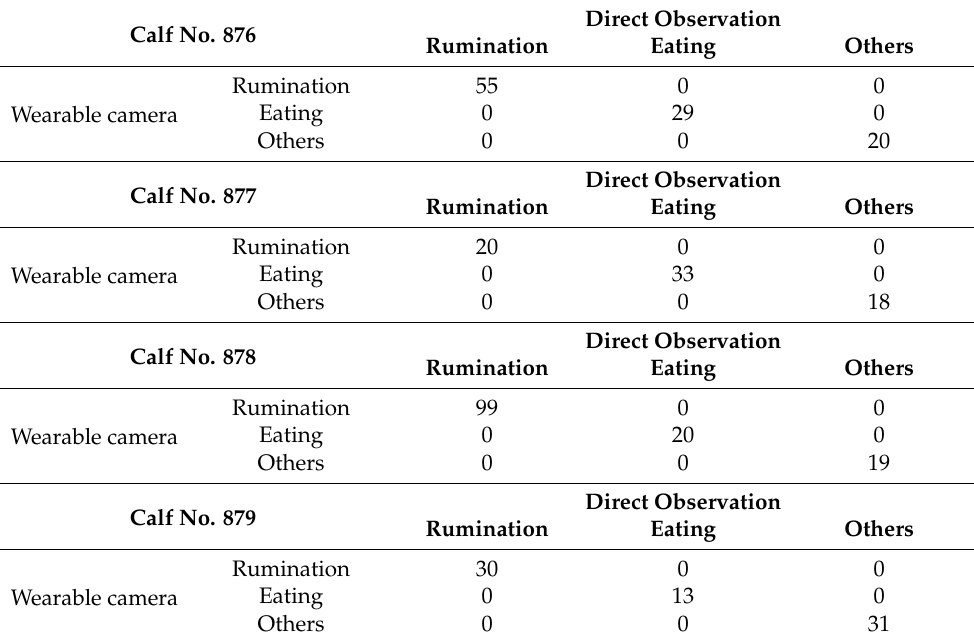
Table 5. Differences between wearable camera observation and direct observation per behavior for each calf.